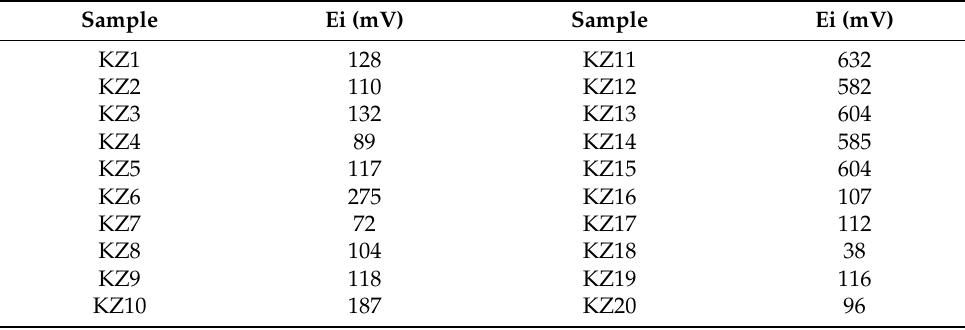
Table 5. Initial electrode potential (Ei) values of the silica-based solid